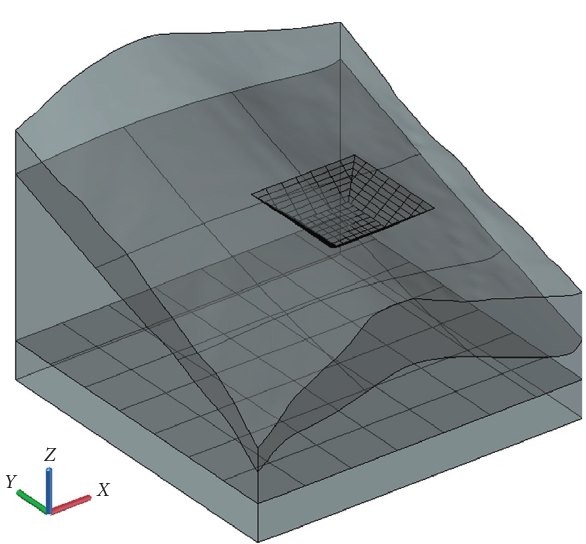
Figure 13: Ground model as visualized in Autodesk AutoCAD.